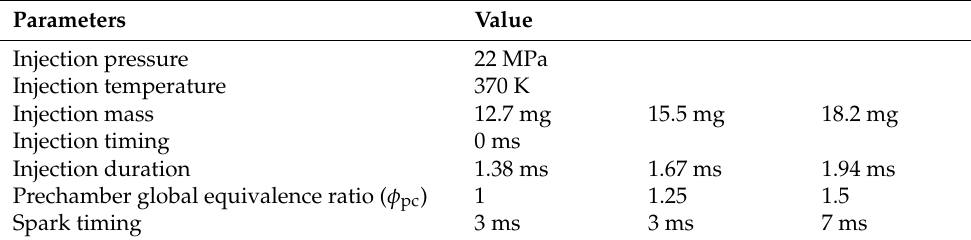
Table 5. The conditions for different prechamber global equivalence ratios.